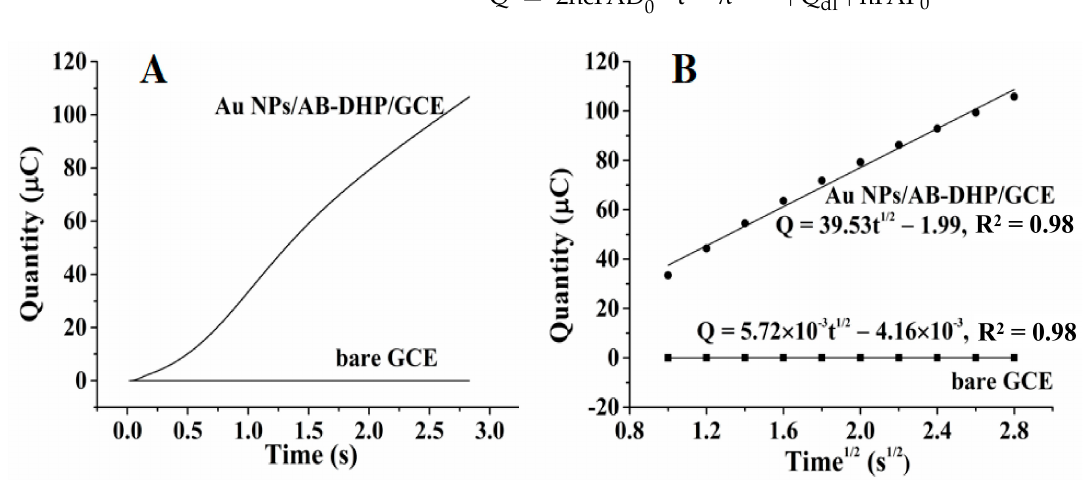
Figure 9. ( A ) Chronocoulomagrams of bare GCE and AuNPs/AB–DHP/GCE in 0.15 M PBS (pH = 6.0) containing 200 µM HcySH. ( B ) The linear relationship between Q and t 1/2 for bare GCE and AuNPs/AB − DHP/GCE.